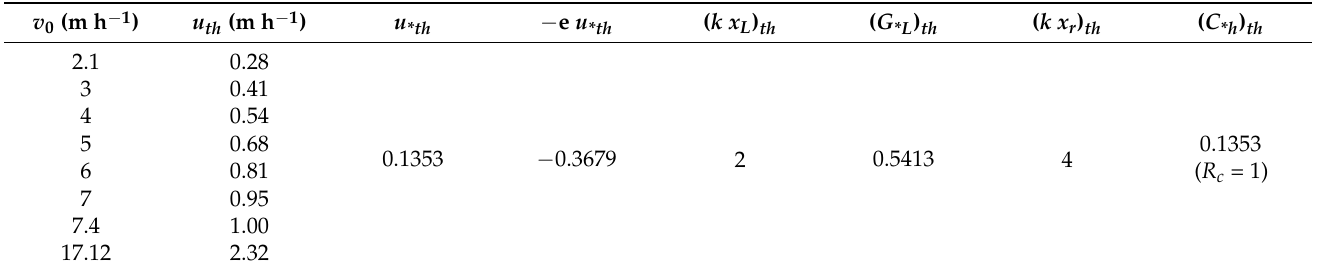
Table 1. For different v 0 values, threshold u values, u th , and the corresponding u *th , − e u *th , ( k x L ) th , ( G *L ) th , ( k x r ) th , and for R c = 1, ( C *h ) th , for which Equation (21) admits real x L